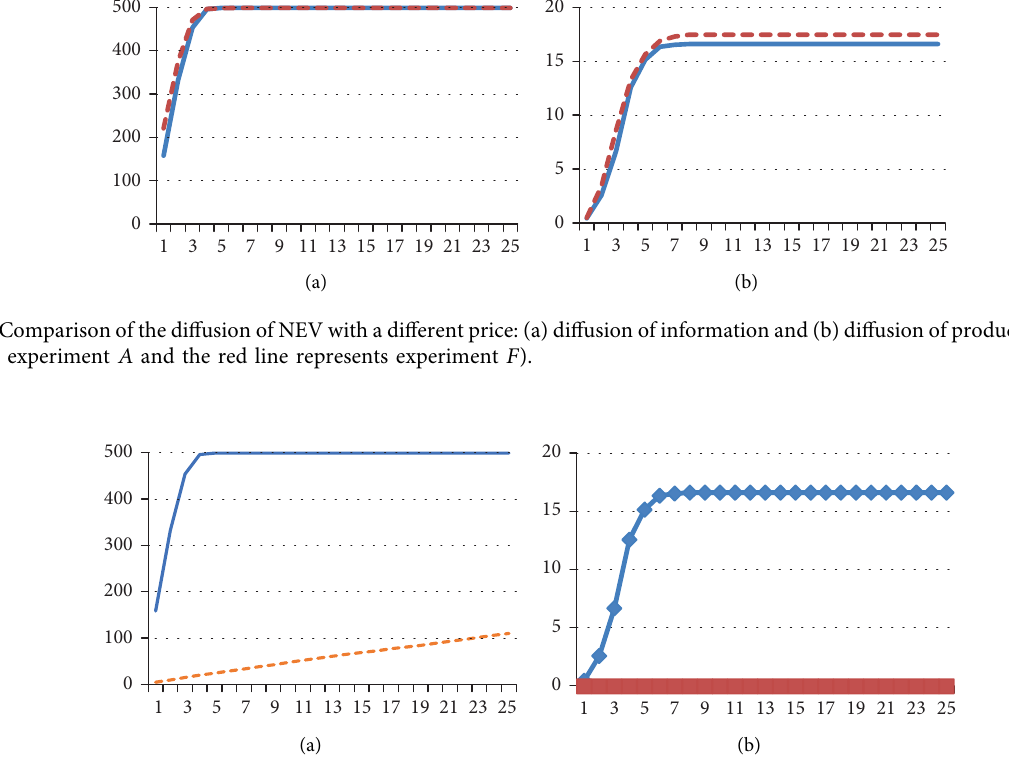
Figure 7: Comparison of the difusion of NEV with diferent trust: (a) difusion of information and (b) difusion of products (Te blue line represents experiment A and the red line represents experiment G ).